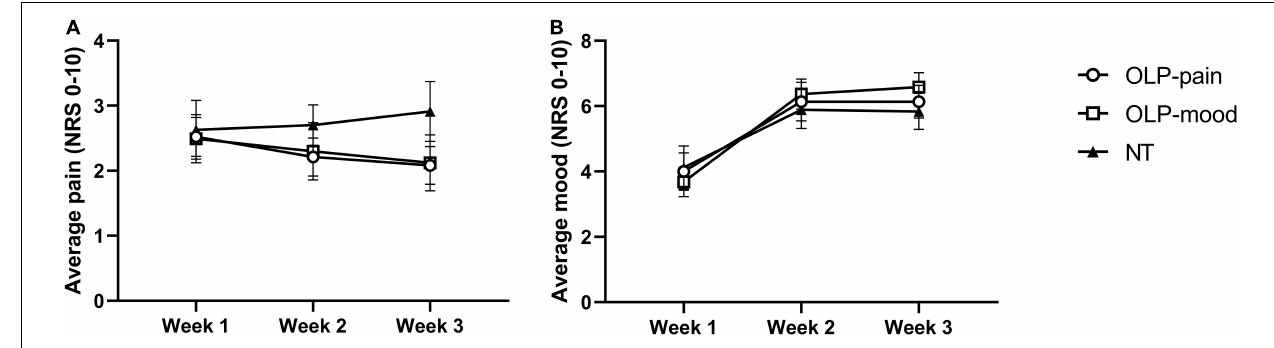
FIGURE 2 | Weekly averages of daily NRS pain ratings (A) and NRS mood ratings (B) . Data are displayed as means ±